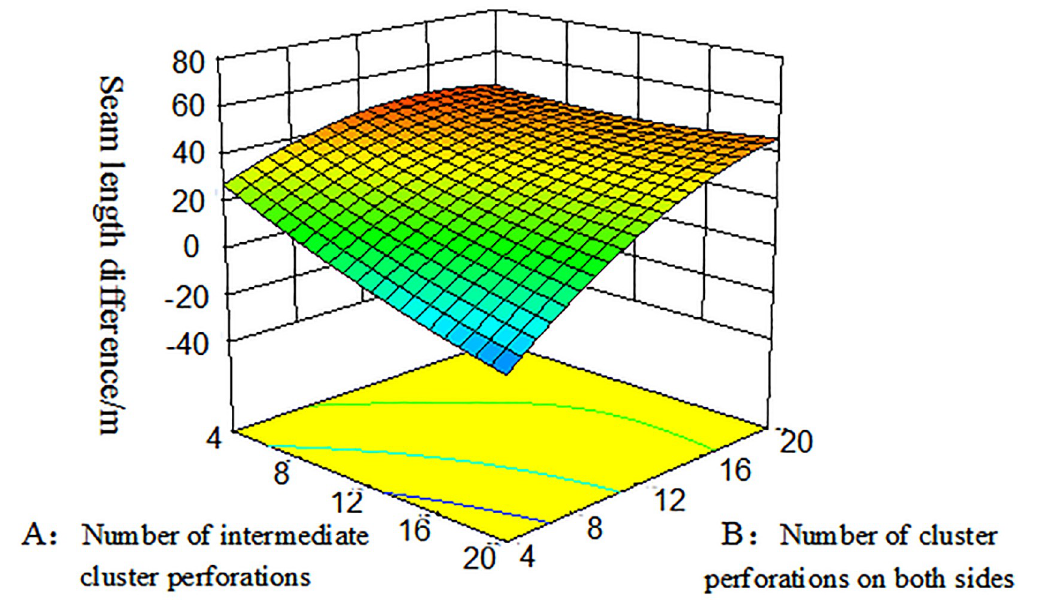
Fig 13. Three-dimensional response surface diagram of the number of intermediate cluster perforations and the number of cluster perforations on both sides on the seam length difference.